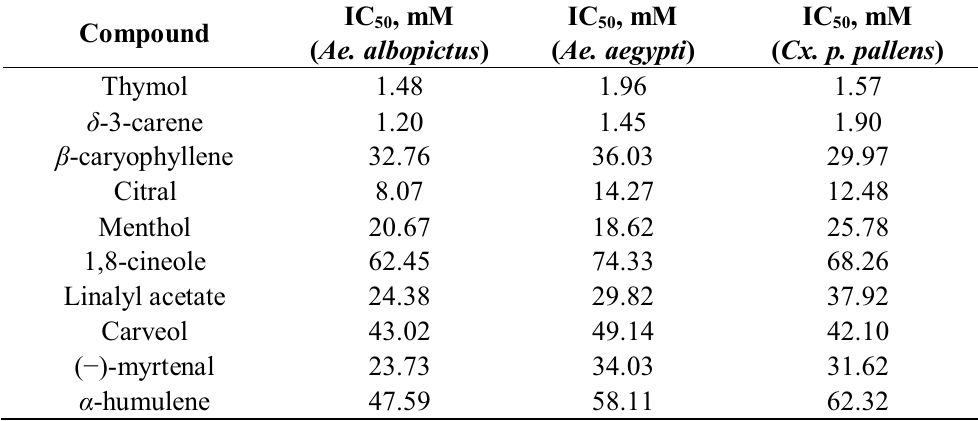
Table 5. In vitro inhibition of acetylcholinesterase (AChE) extracted from the heads of larval Ae. albopictus , Ae. aegypti and Cx. p. pallens by 10 selected